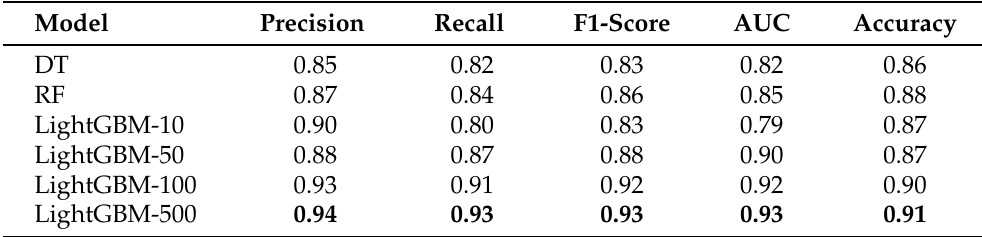
Table 1. Model evaluation. Standard classification performance metrics measured on the test set. The best performance is achieved with the LightGBM model with 500 gradient boosting iterations.